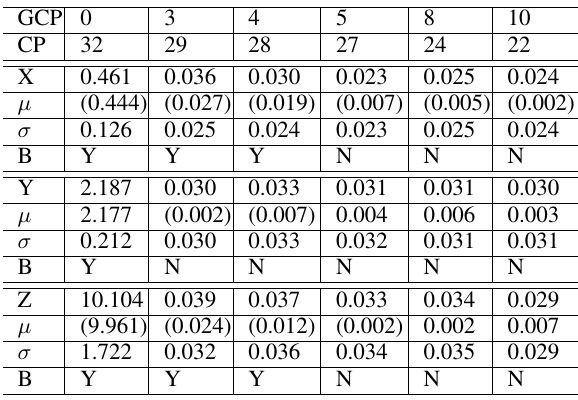
Table 2. Statistics of photo-triangulation with fixed